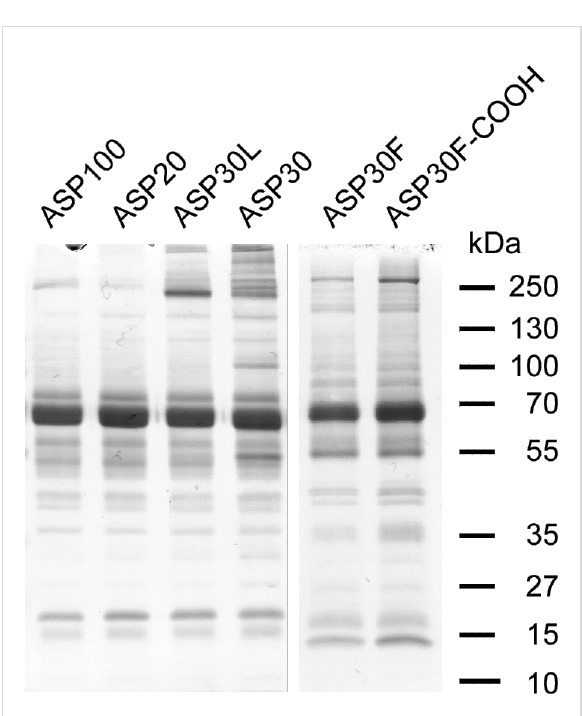
Figure 8: SDS-PAGE analysis to demonstrate the efficient formation of a protein corona around ASP. The indicated ASP suspensions were incubated with human plasma for 1 h. ASP–protein complexes were recovered by centrifugation, washed with buffer A, and the proteins were resolved by 1D SDS-PAGE. Corona proteins were visualized by Coomassie brilliant blue R-250 blue staining. MW is